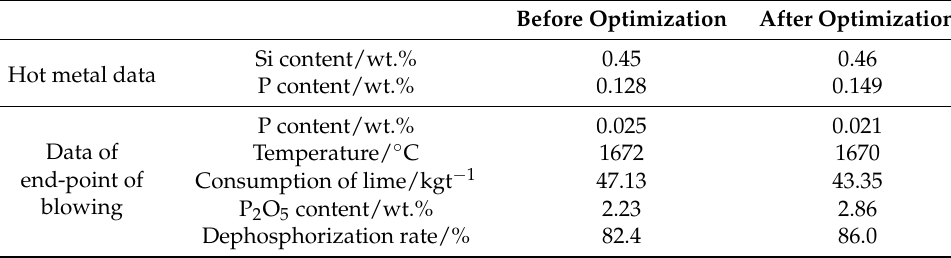
Table 4. Comparison of metallurgical effect before and after the optimization of slag-forming route. Before Optimization After Optimization Si Hot metal data